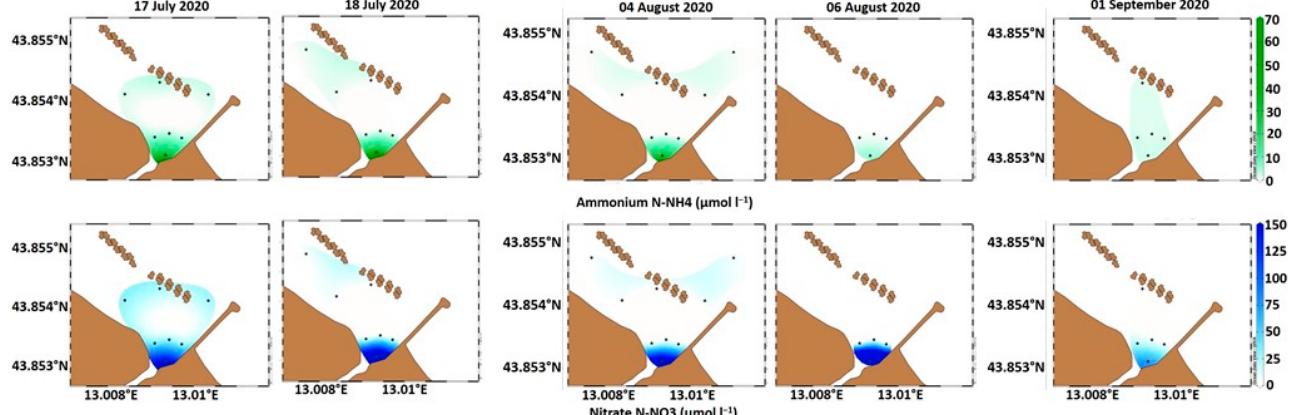
Figure 5. Ocean data view [15] maps showing the spatial distributions of nutrient concentration (NH 3 and NO 3 ) in seawater from sampling stations to offshore along the three transects in front of the Arzilla mouth during the 2020 rainy events (July, August and September). The graphs show the relative abundance of ammonium (in green) and nitrates (in blue).